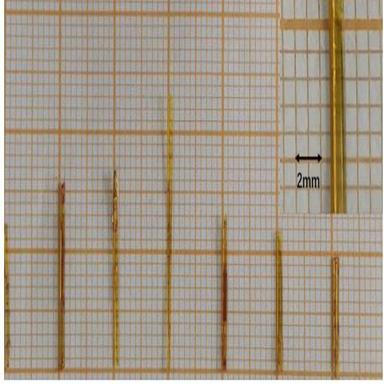
Grown DADMQ crystal in methanol.